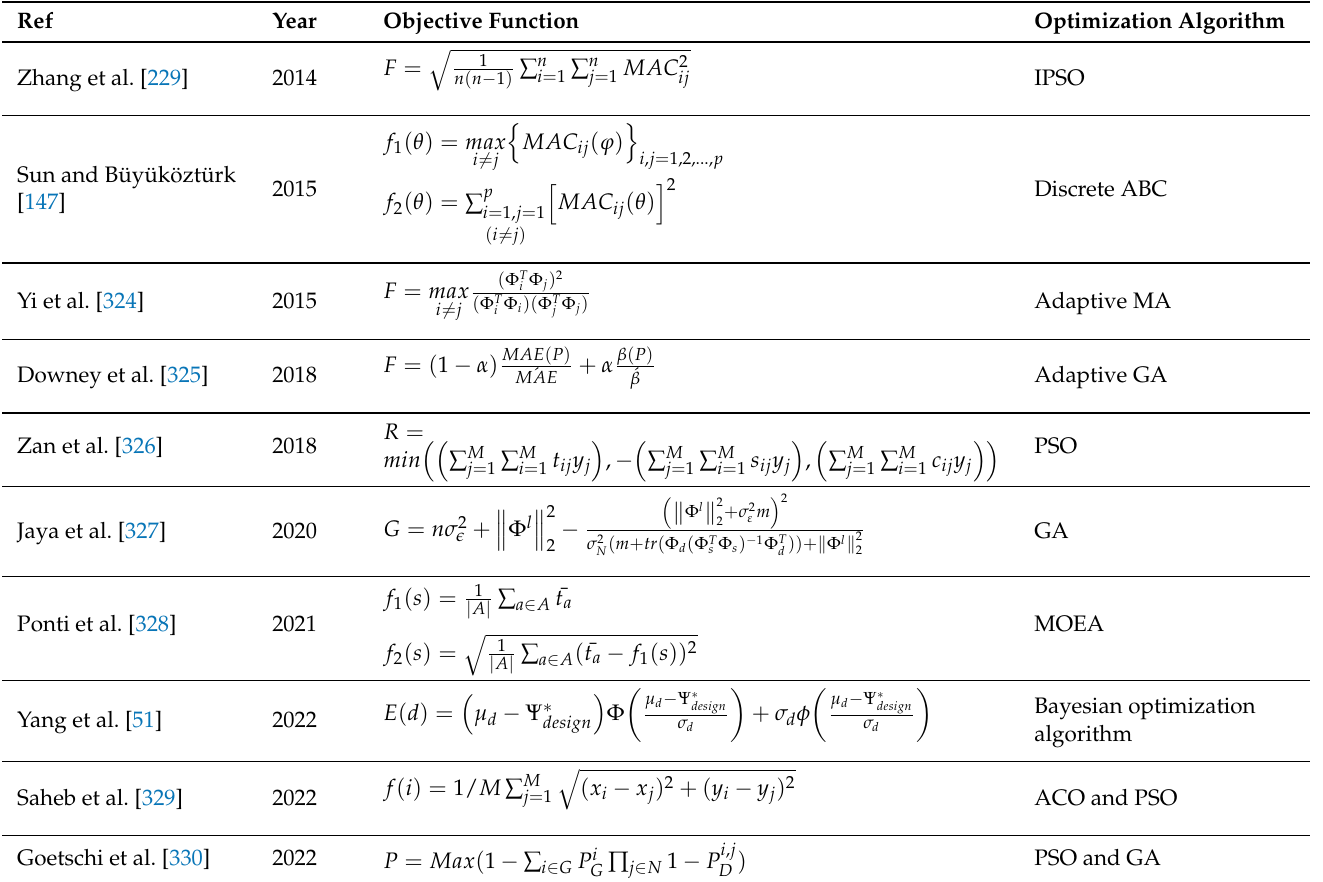
Table 18. Applications of optimization algorithms in OSP methods.